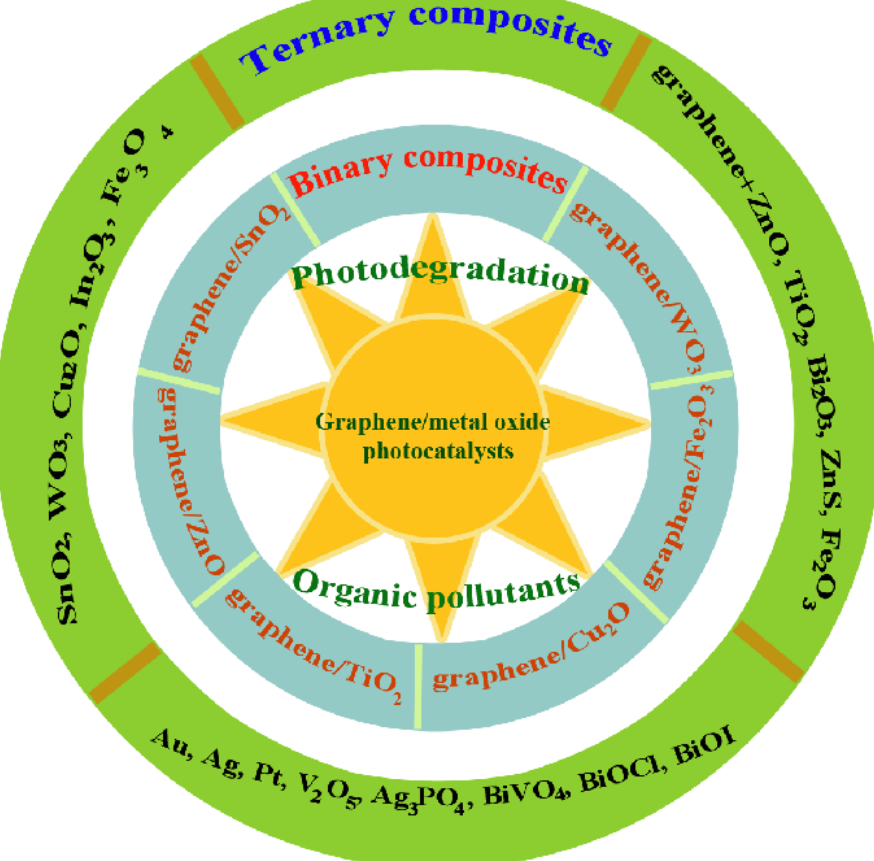
Figure 1. The graphene/metal oxide binary and ternary composite photocatalysts for wastewater Figure 1. Thegraphene / treatment.